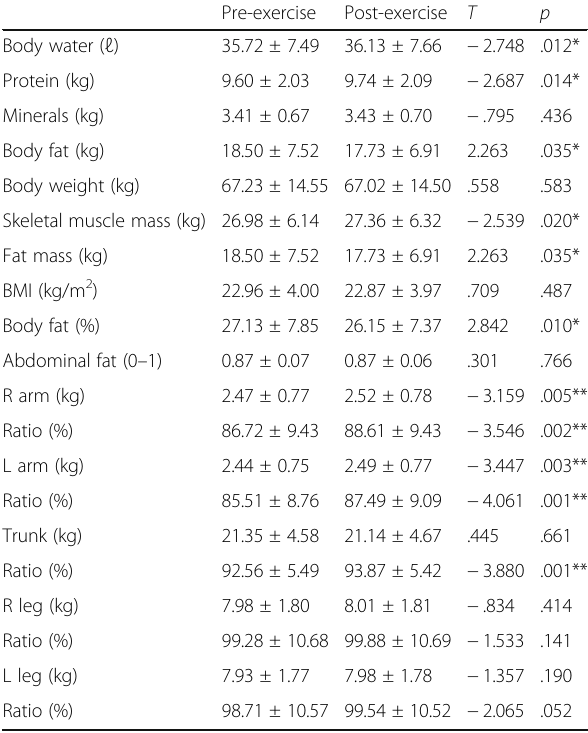
Table 2 The effect of sports VR training on human body composition Pre-exercise Post-exercise T